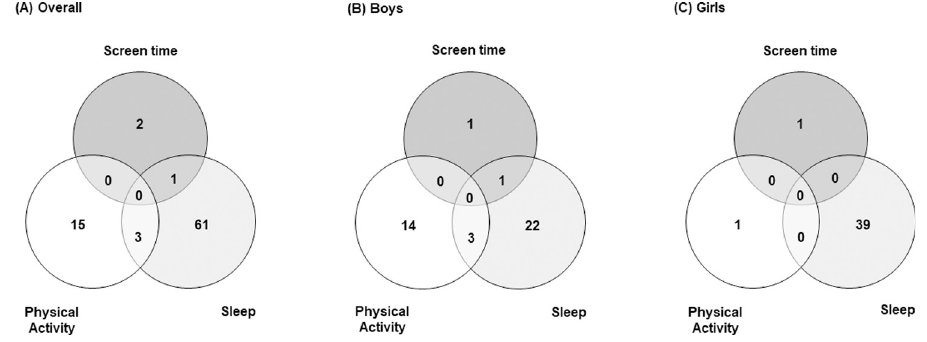
Fig 2. Participants’ compliance with the behavior guidelines. (A) Overall.(B) Boys. (C) iGrls.